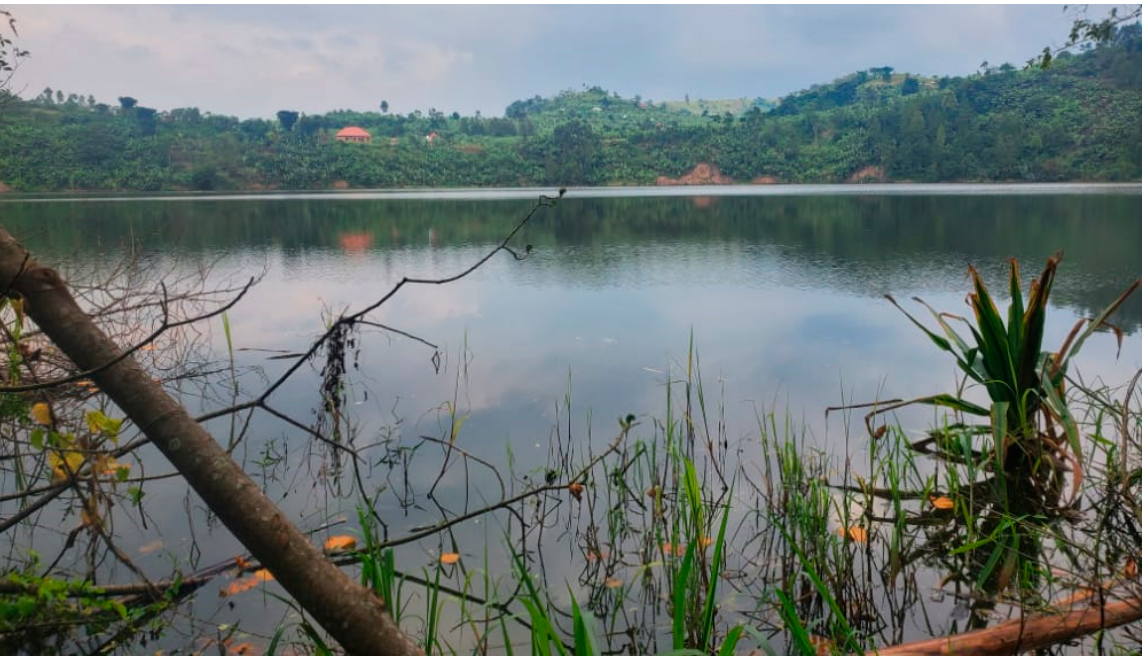
Figure 3. Brackish water in Lake Kamweru, a cyanobacteria-rich twin crater lake in Rubirizi district, Western Uganda. The lake and its twin (Lake Kyema) are the only co-joined lakes in Africa, which are filled by water from a heritage cave (photo credit: Ivan Kahwa, December 2022).